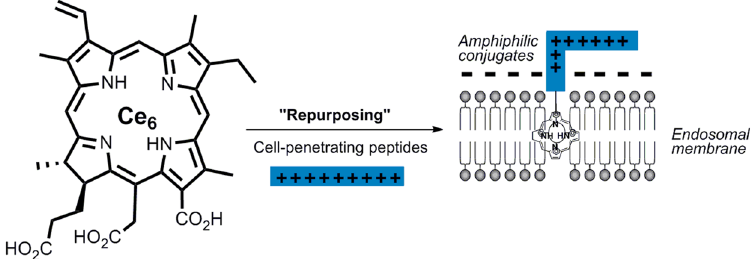
Figure 1. Concept of interfacial lipid membrane localisation of a chlorin e 6 (Ce 6 ) cell-penetrating peptide conjugate for light-triggered endosomal membrane rupture following oxidation of membrane components (eg unsaturated lipids) by reactive oxygen species.